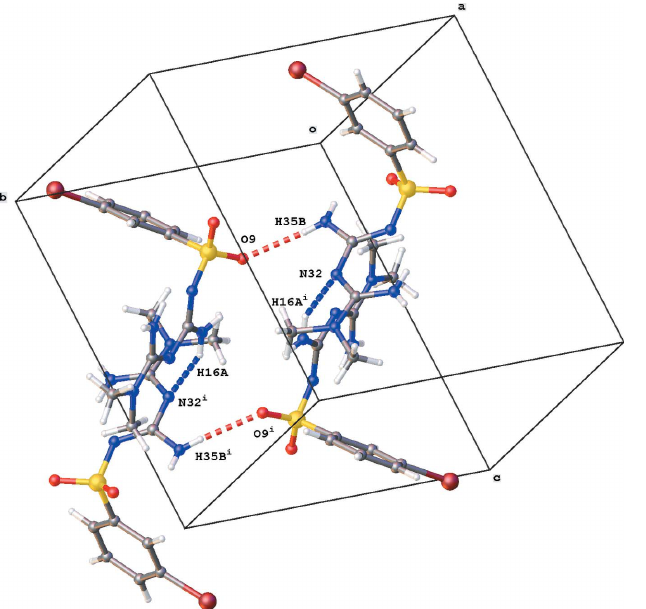
Figure 4 Partial crystal packing of the title compound, showing R 4 4 (20) ring formation through N—H (cid:2)(cid:2)(cid:2) N and N—H (cid:2)(cid:2)(cid:2) O hydrogen bonding shown as blue and red dashed lines, respectively. Symmetry code: (i) (cid:4) x , (cid:4) y + 1, (cid:4) z + 1 .